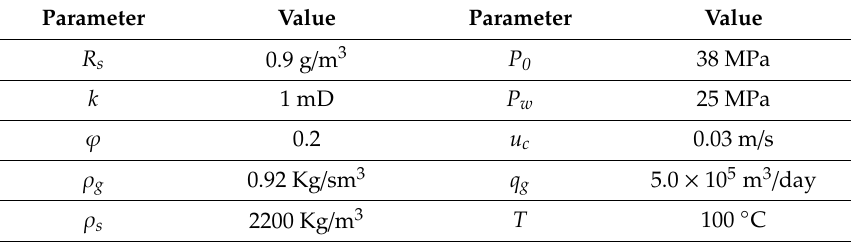
Table 1. Basic parameters in numerical